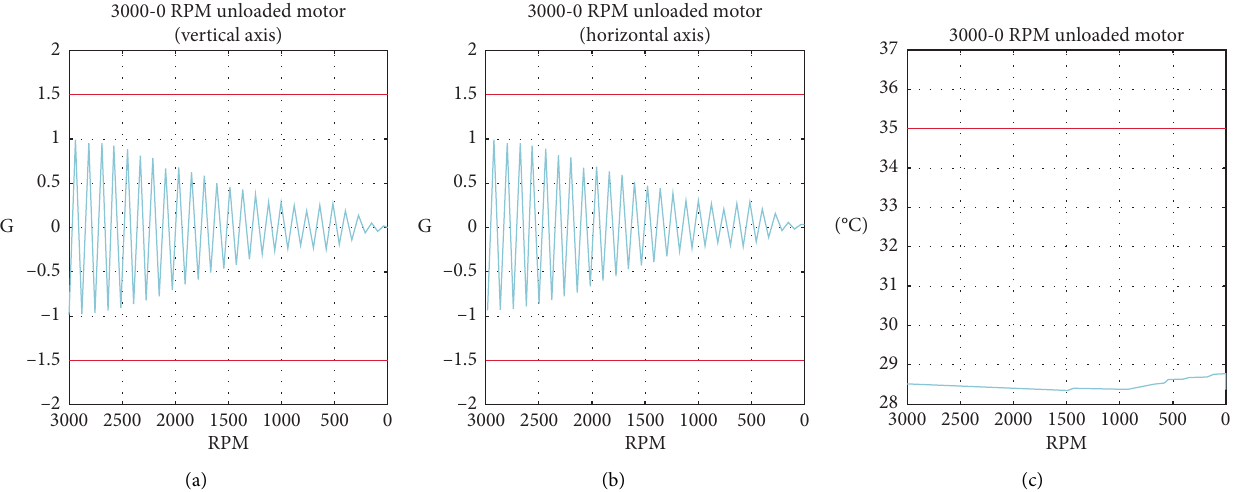
Figure 6: The 3000–0 RPM measurement-speed graph of the unloaded motor: (a) vertical axis, (b) horizontal axis, and (c) temperature- speed graph of the unloaded motor.